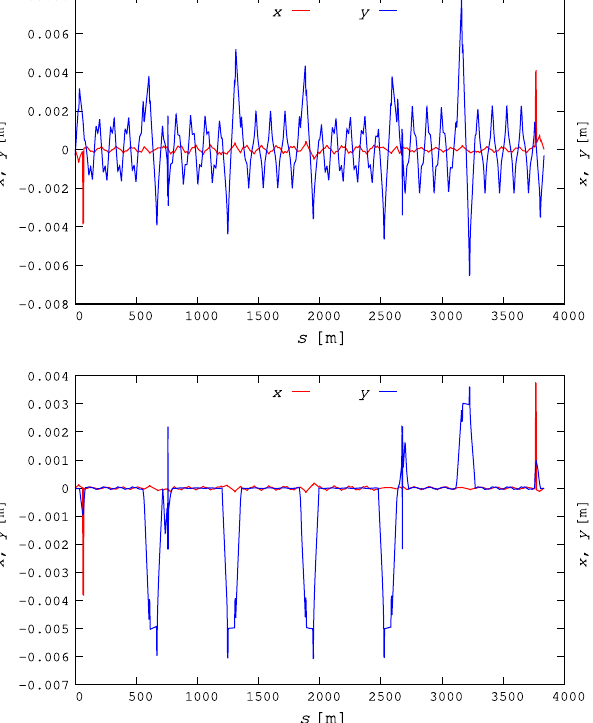
FIG. 27. RHIC Yellow ring, 255 GeV. This lattice includes the 16 OPERA field maps of the 9 o ’ clock and 3 o ’ clock snakes, and STAR rotators, the latter set for rotation of spin ⃗ n 0 to longitudinal at IP6. Origin of s is at IP6, location of the STAR detector. Top: closed orbit excited when introducing the 16 field maps in the lattice, prior to correction. Bottom: after correction, based on local closed orbit bumps at both rotators and both